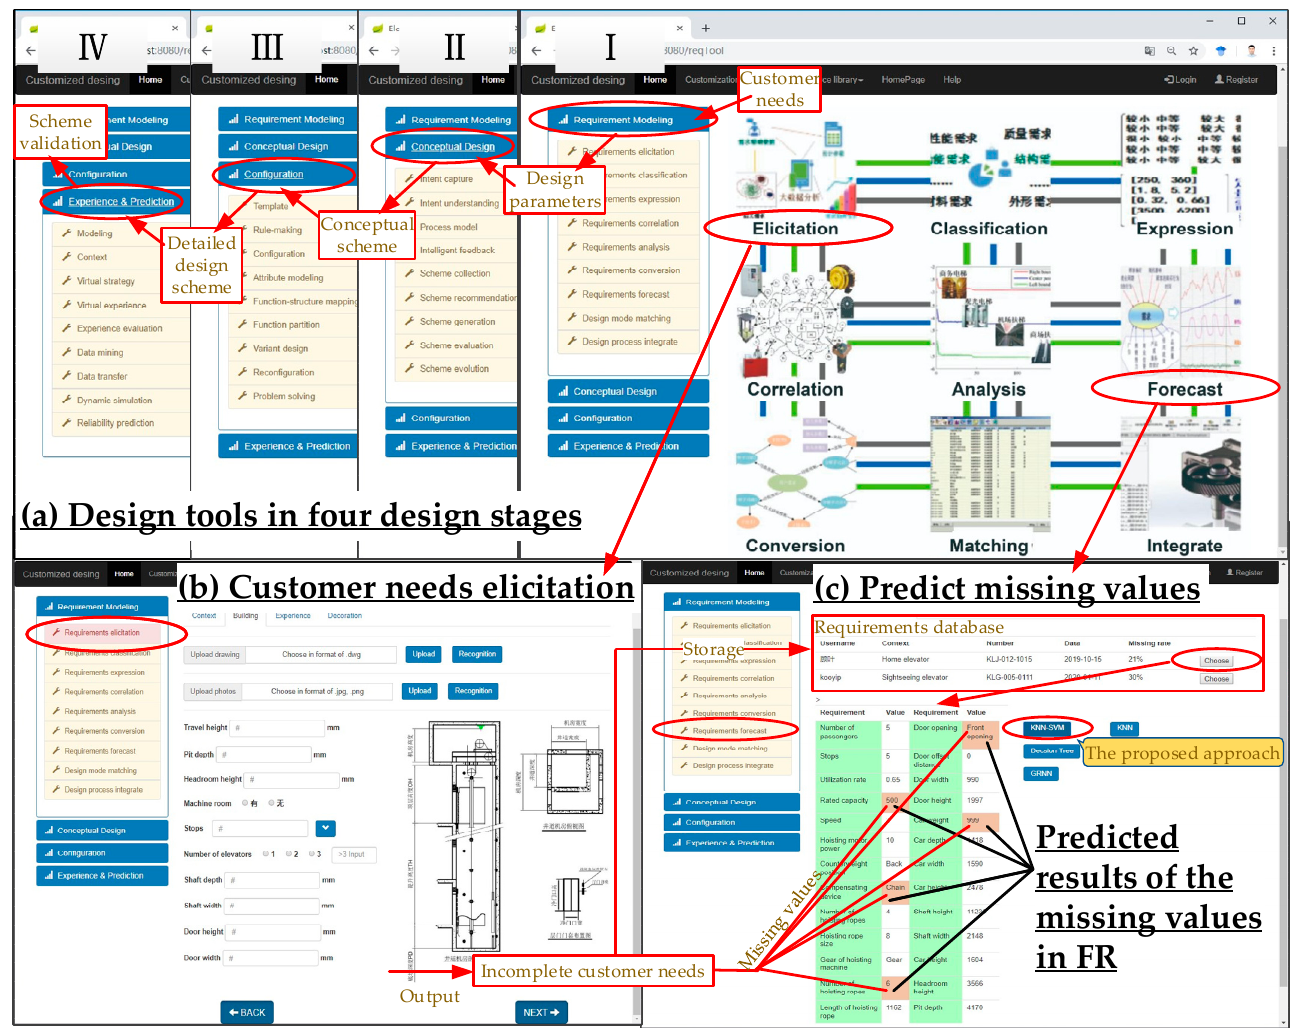
Figure 7. User interface of the developed customized product design